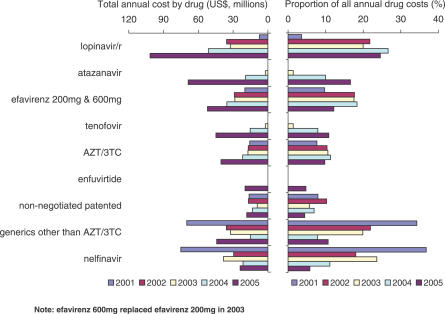
Total Annual Cost by Drug (Left) and Proportion of All Annual Drug Costs (Right)